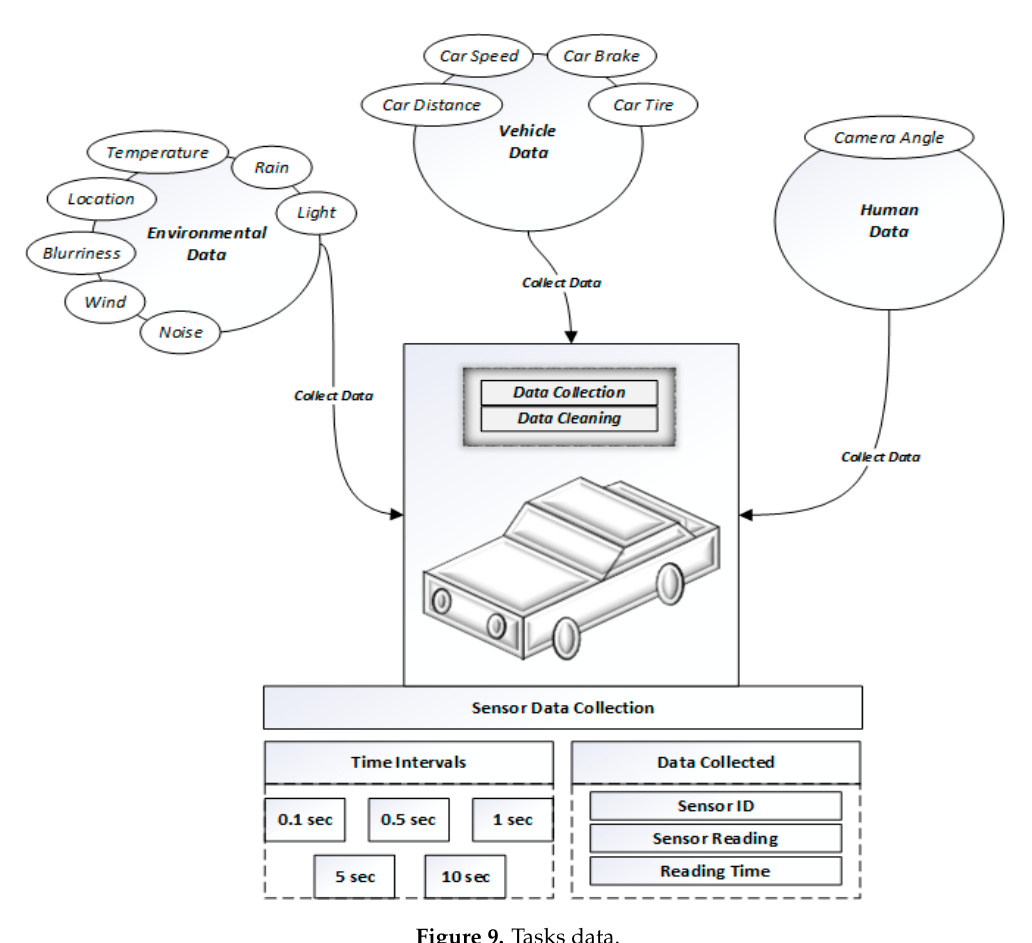
Figure 9. Tasks Figure 9. Tasks data.